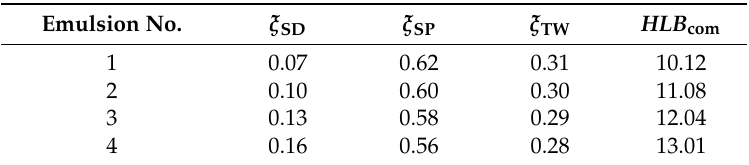
Table 1. HLB (hydrophilic–lipophilic balance) values of the compound emulsifiers with different mixing ratios.